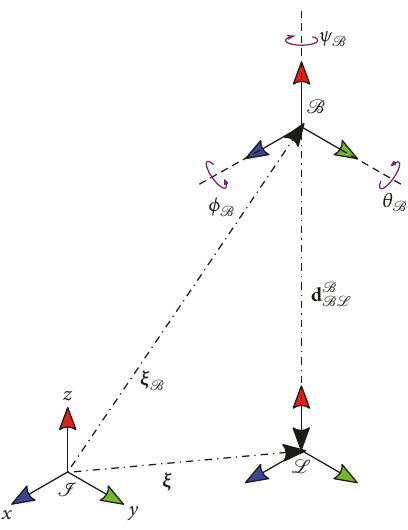
Figure 3: Tilt-rotor UAV pose and load’s position measured by the available